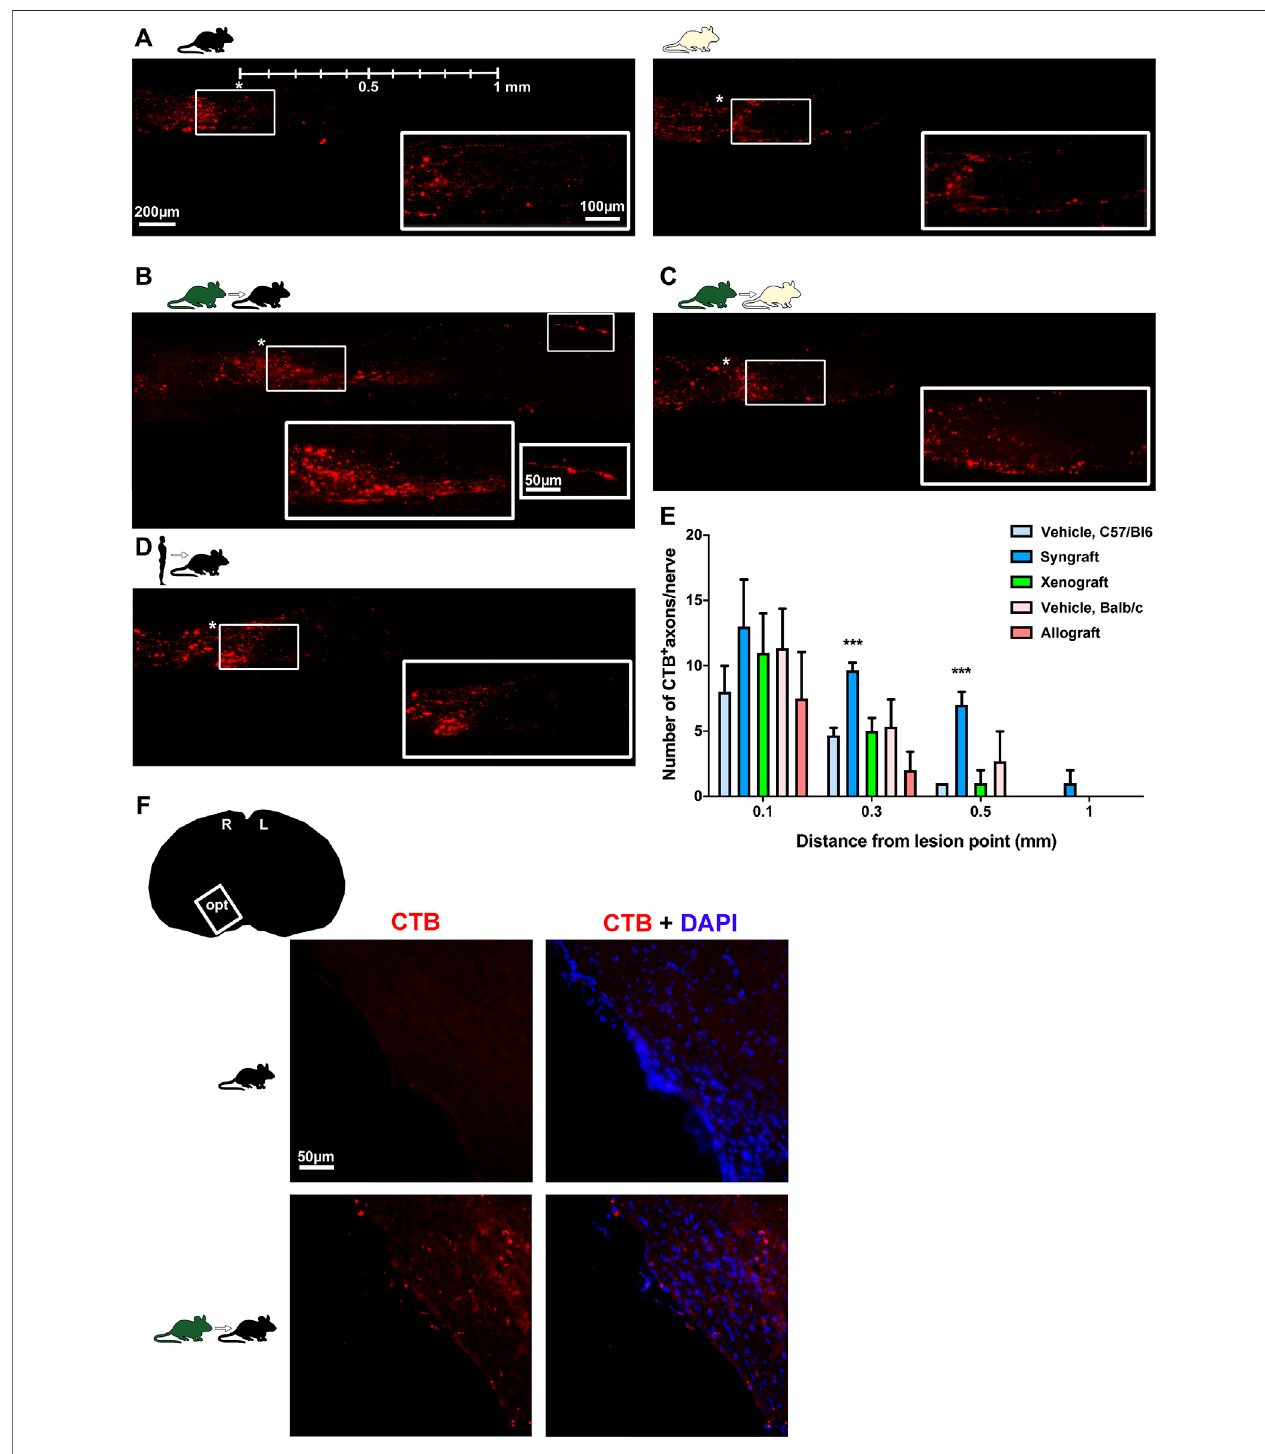
FIGURE 7 | Syngeneic transplant supports axonal regeneration. (A – D) Photomontages of cleared optic nerves showing CTB-anterogradely traced RGC axons 90 days after ONC in vehicle-treated retinas, and BM-MSC-transplanted retinas. magni fi cations on the bottom right are from the framed areas. Lesion site is marked with an asterisk. Rostral left, caudal, right. n (cid:2) 3 nerves/group. (E) : Mean number ± SD of CTB + axons quanti fi ed at increasing distances from thelesion site (*** p < 0.001Kruskal-Wallistest,Dunn ’ smultiplecomparisonstest). (F) :CTB + axonsintheoptictractwereobservedinoneanimal fromthesyngeneicgroup( n (cid:2) 3